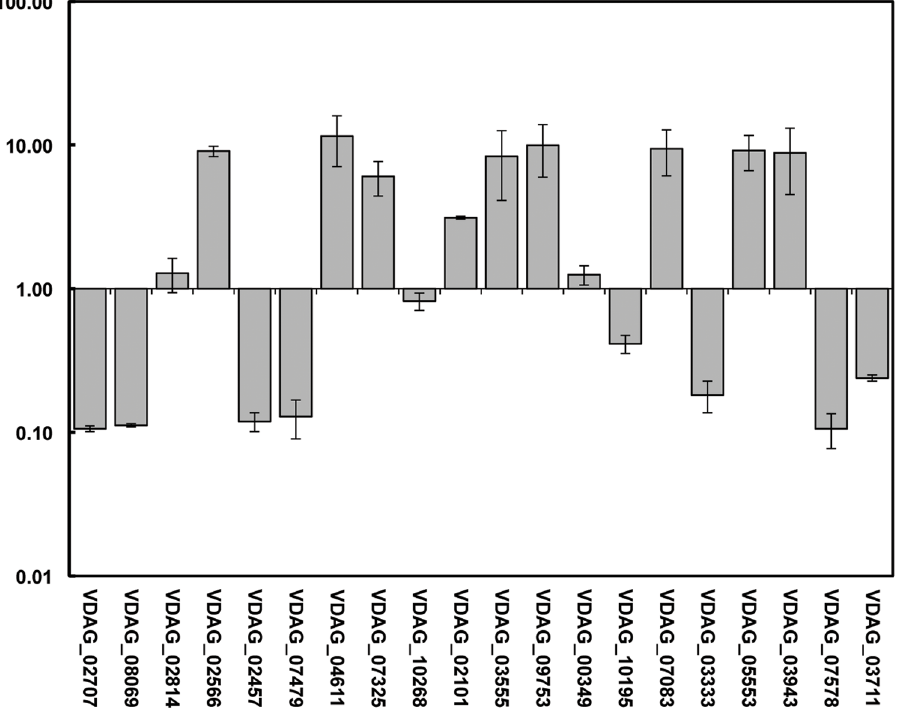
Figure 7. Relative expression level of 20 randomly selected genes from the 40 most differentially expressed genes that were up- regulated or down-regulated in the germinated Verticillium dahliae microsclerotia (VDMG-b) comapred with non-germinated Verticilliumdahliae microsclerotia (VDM) by quantitative real-time reverse transpcription PCR. The expression ratio of each gene was calculated from cycle threshold (CT) values using 2 2 DD CT method [24]. Mean expression and error were determined using the REST (Relative Expression Software Tool) [25] with beta-tubulin gene as reference gene.